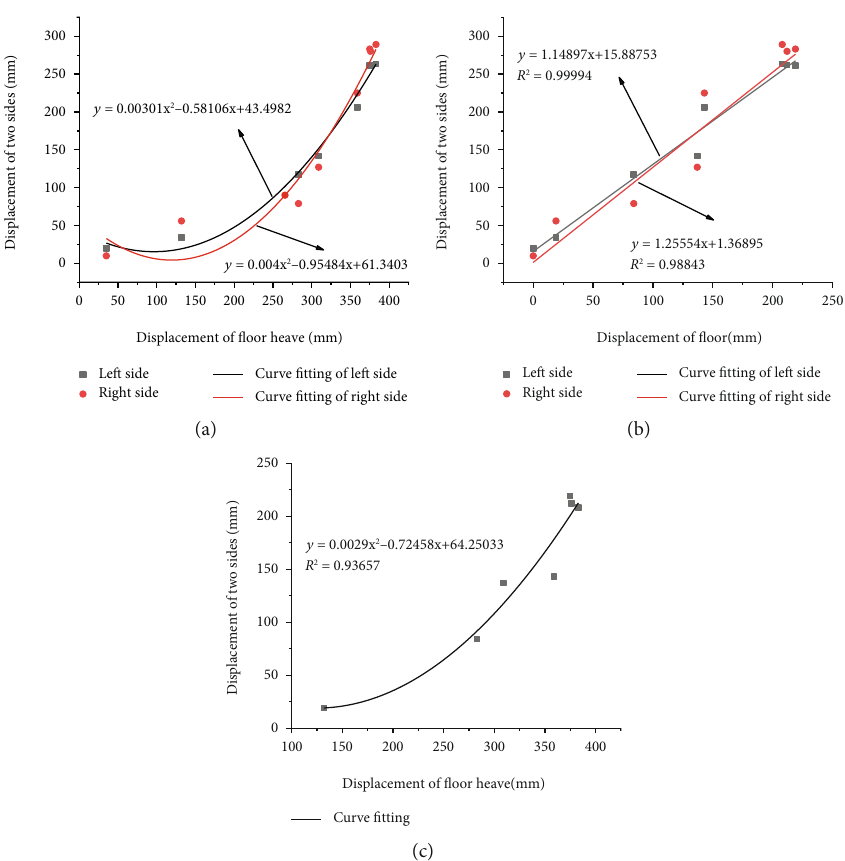
Figure 11: The displacement relationships between the fl oor heave, two sides, and roof. (a) The relationship between fl oor heave and the displacement of the two sides. (b) The relationship between roof subsidence and the deformation of the two sides. (c) The relationship between roof subsidence and fl oor heave.